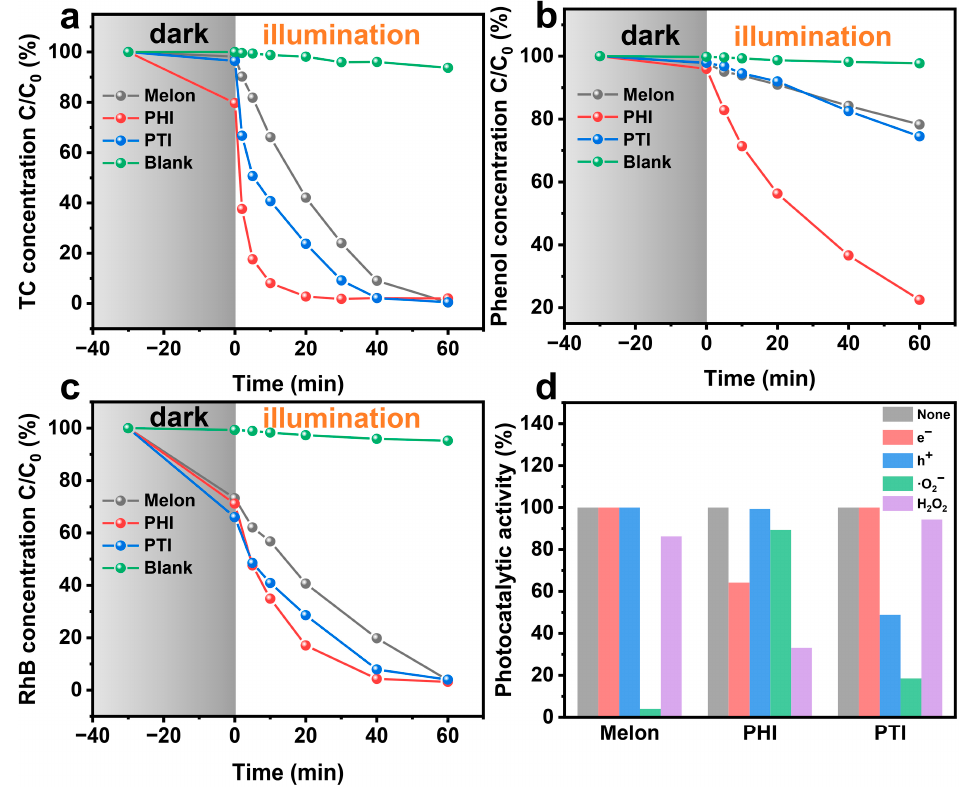
Figure 7. Photocatalytic e ffi ciency of the g-C 3 N 4 samples ( a ): Degradation of phenol (10 mg·L − 1 ). ( b ): Degradation of TC (50 mg·L − 1 ). ( c ): Degradation of RhB (10 mg·L − 1 ). ( d ): Photocatalytic activity for the degradation of TC with the introduction of multiple scavengers.